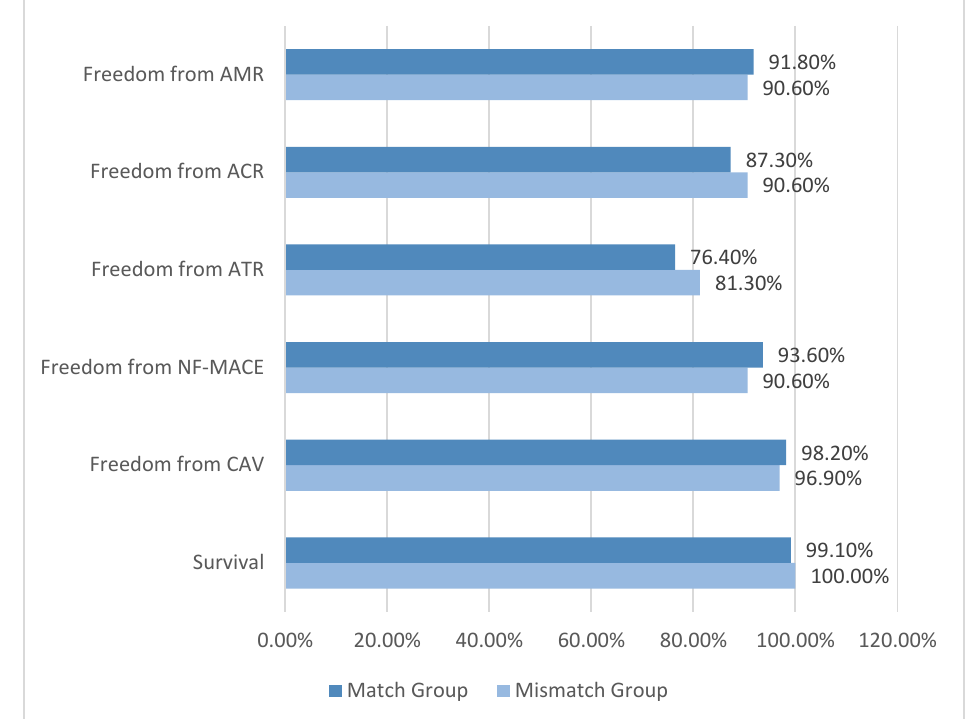
Figure 2. Post-Transplant Outcomes at One Year Post-HTx.